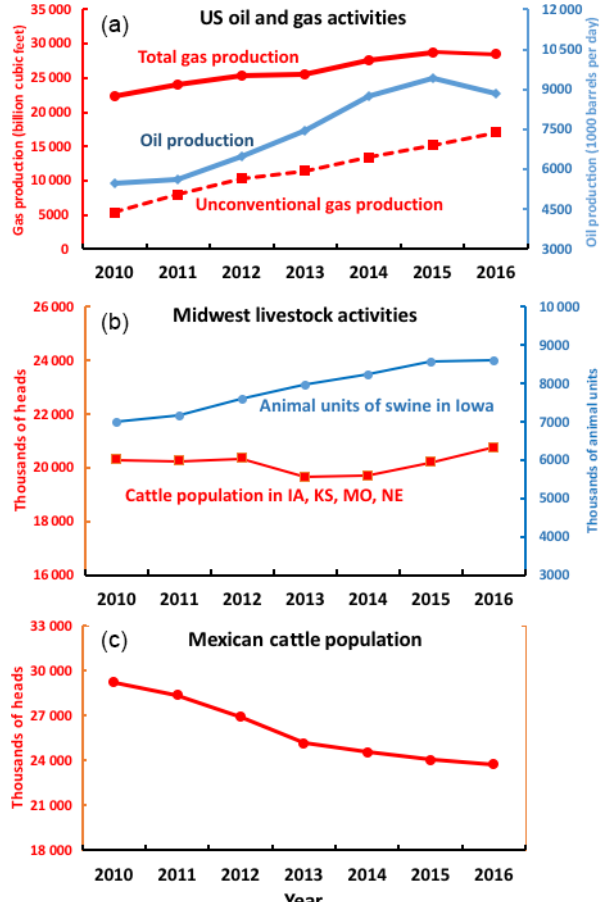
Figure 5. The 2010–2016 changes in methane-emitting activities. (a) Oil and natural gas production in CONUS (Drillinginfo, 2016). (b) Cattle population in Iowa, Kansas, Missouri, and